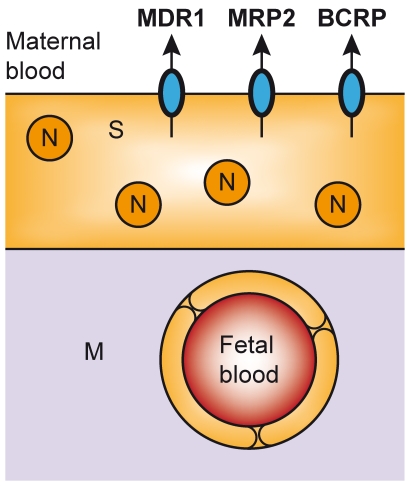
Localization of MDR1, MRP2, and BCRP in placenta.The syncytiotrophoblast (S) layer of the placenta is comprised of multinucleated (N) cells that contain a number of apically-localized transport proteins that contribute to the function of the placental barrier, including MDR1, MRP2, and BCRP.